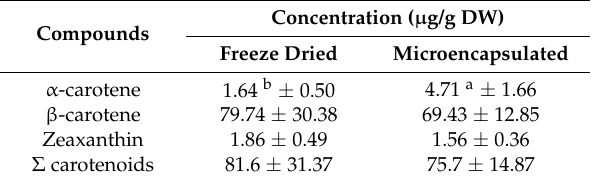
Table 3. Carotenoid composition in freeze dried and microencapsulated banana passion fruit